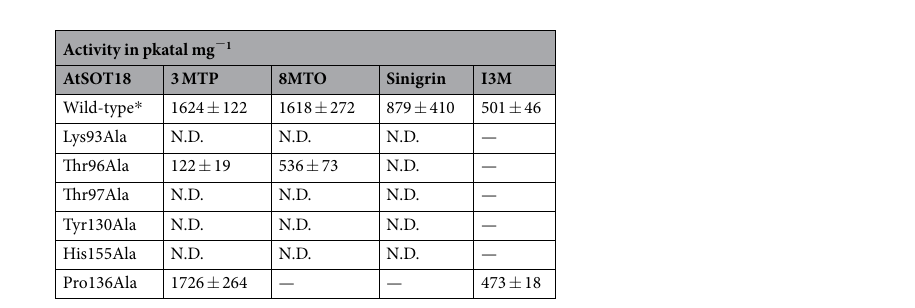
Table 1. Mutational analysis of the AtSOT18 enzyme. Selected amino acids in the catalytic centre were mutated to alanine. The activity was tested with short-chained aliphatic 3 MTP, long-chained aliphatic Gl 8MTO, co- crystallized sinigrin and indolic Gl I3M. The 150 µ L assays contained 80 mM Tris/HCl, pH 8.0, 9.2 mM MgCl 2 , 60 µ M of the respective ds-Gl substrates, 1 µ g purified protein, and 60 µ M PAPS. The reactions were started by the addition of PAPS, incubated for 20 min at 37 °C, and stopped by incubation at 95 °C for 10 min. The formation of the respective sulphated product was analysed by HPLC at 229 nm. The specific activities are given in pkatal mg − 1 . N.D., not detectable; (—), not